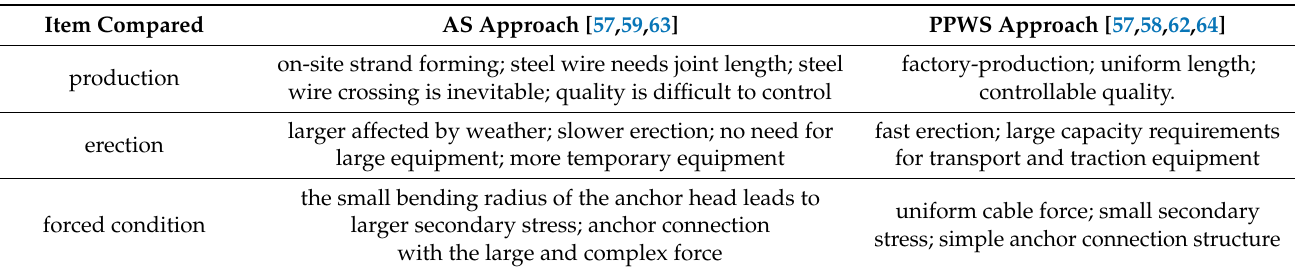
Table 1. Summary of characteristics of two methods.